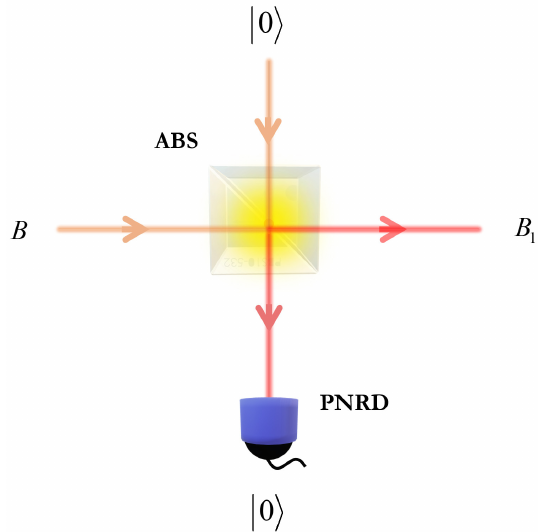
Figure 3. The ZPC operation for the NA-based source preparation. ABS: asymmetrical beam splitter. PNRD: photon number resolving